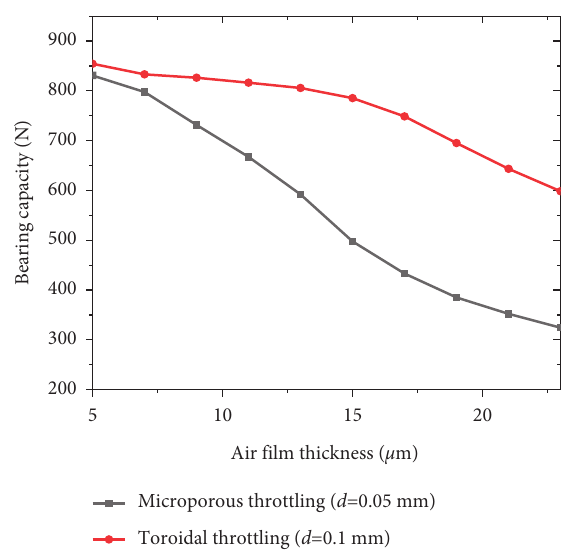
Figure 13: Comparison of microporous throttling and toroidal throttling